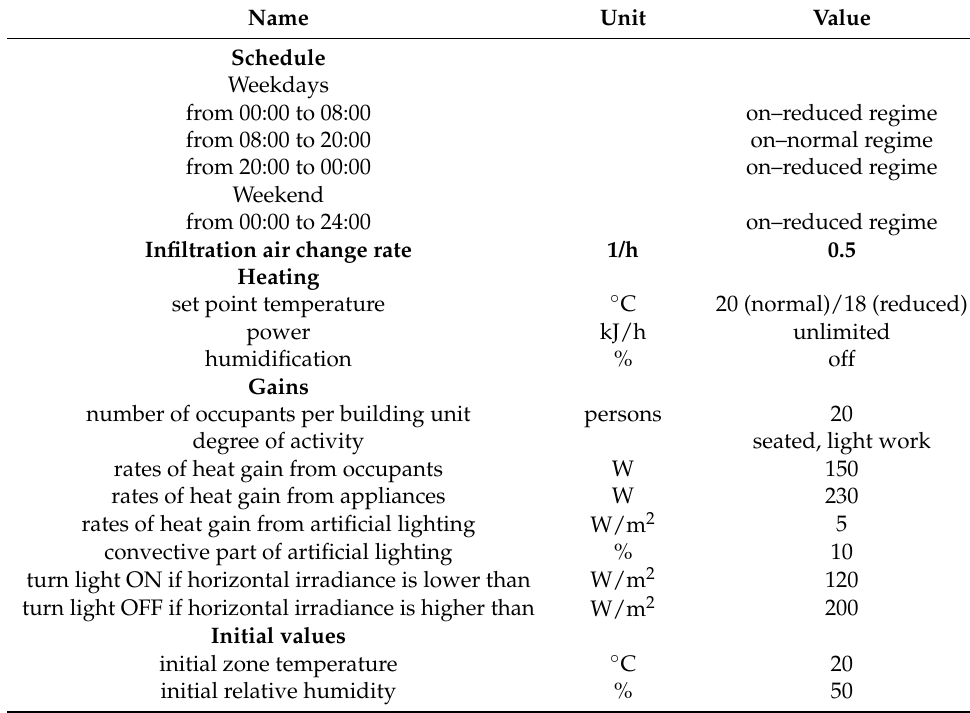
Table 5. Regime data for each